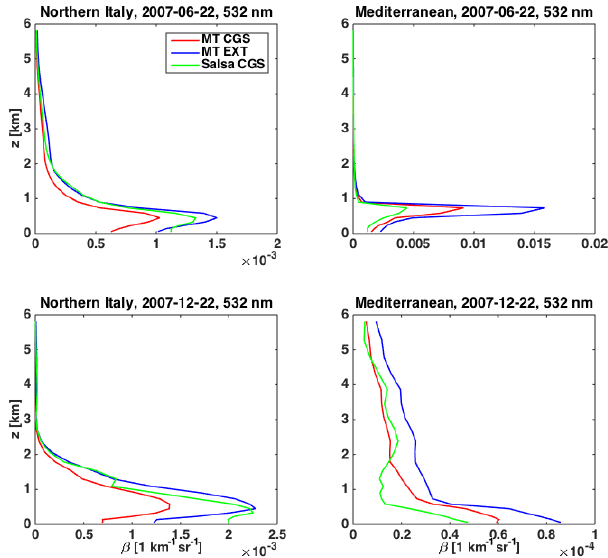
Figure 11. Backscattering coefficient at a wavelength of 532nm in northern Italy and the Mediterranean and at two different time events (22/6 and 22/12/2007 at 12.00), computed with the three model versions: MT-EXT (blue), MT-CGS (red), and SALSA-CGS